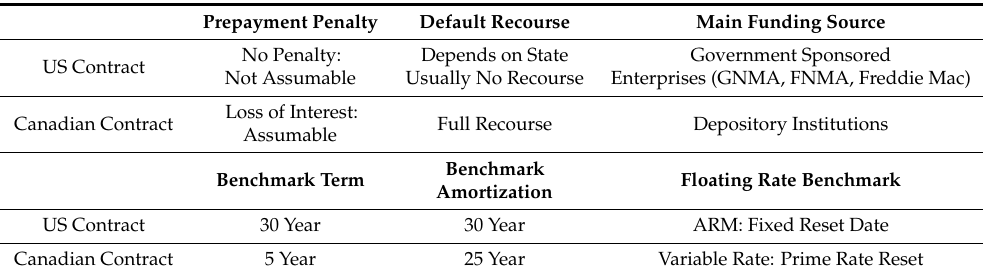
Table 1. Comparison of US and Canadian Mortgage